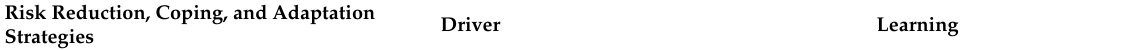
Table 2. Local community-level factors of coping and adaptation